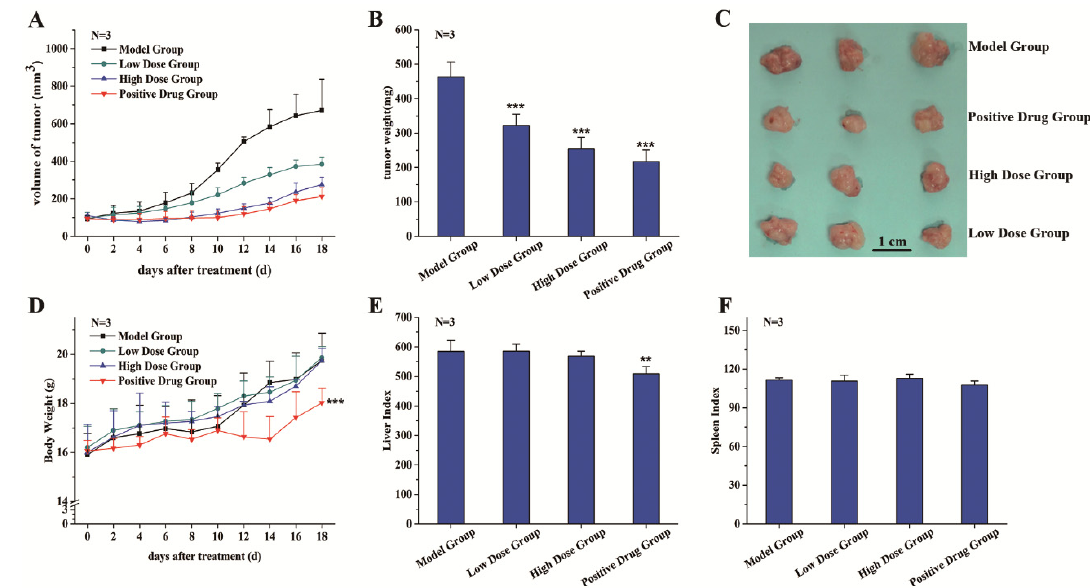
Figure 2. Effects of purified C3G on tumorigenesis in vivo. ( A ) The volumes of tumors were monitored at the indicated times; ( B ) tumor weights were measured after rats were sacrificed; ( C ) photographs of individual tumor xenografts removed from mice; ( D ) the body weights were monitored every alternate day after treatments; ( E ) the liver index and ( F ) the spleen index. The index was calculated as liver weight (mg)/body weight (g); and spleen weight (mg)/body weight (g), respectively. Values are mean ± SEM of three mice. ** p < 0.01, *** p < 0.001.